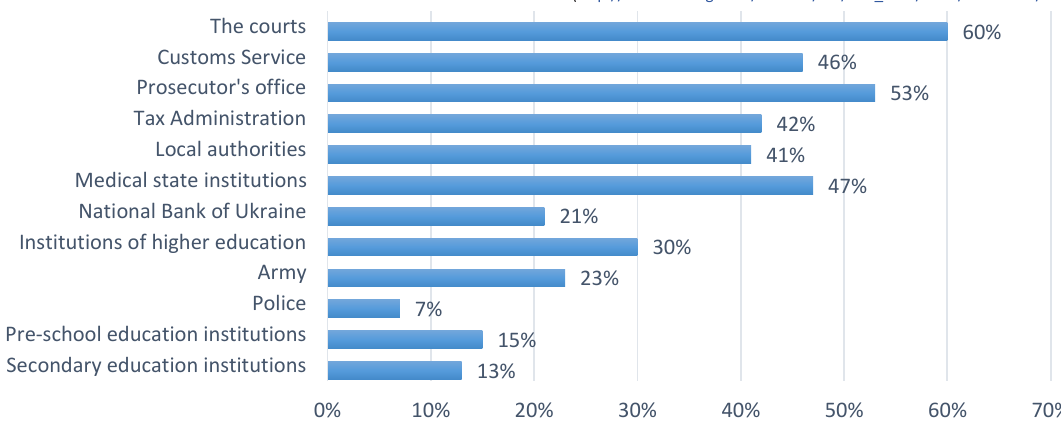
Source: Developed by the authors on the basis of State Financial Monitoring Service of Ukraine (2016)